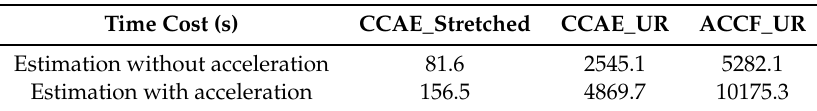
Table 4. Comparison of the time cost between CCAE on stretched signals, CCAE on UR signals and ACCF on UR signals.